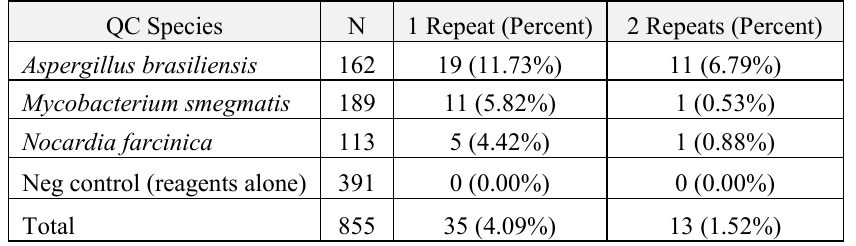
Table 3: Number and Percent of Repeat QC Testing